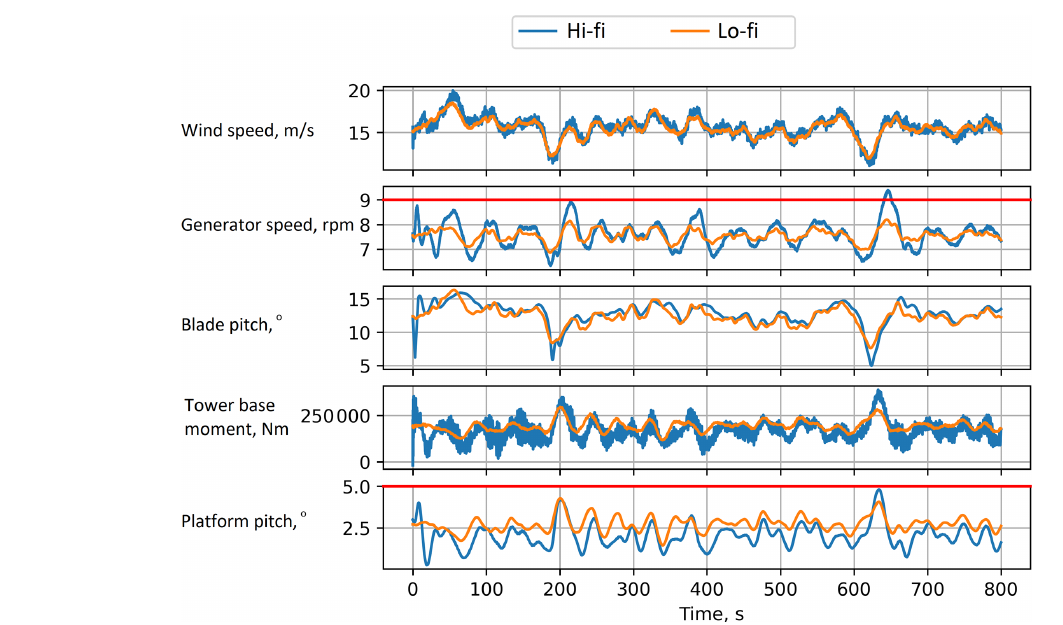
Figure 7. Comparison between the time histories generated from the nonlinear and linearized OpenFAST simulations. The linearized model generally has a smoother response than the nonlinear simulation.